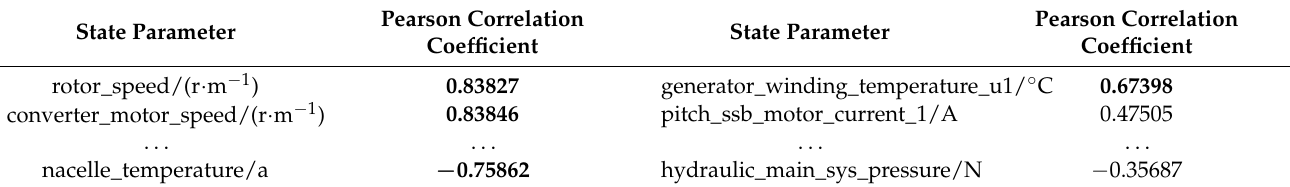
Table 4. Pearson correlation coefficient between each parameter and